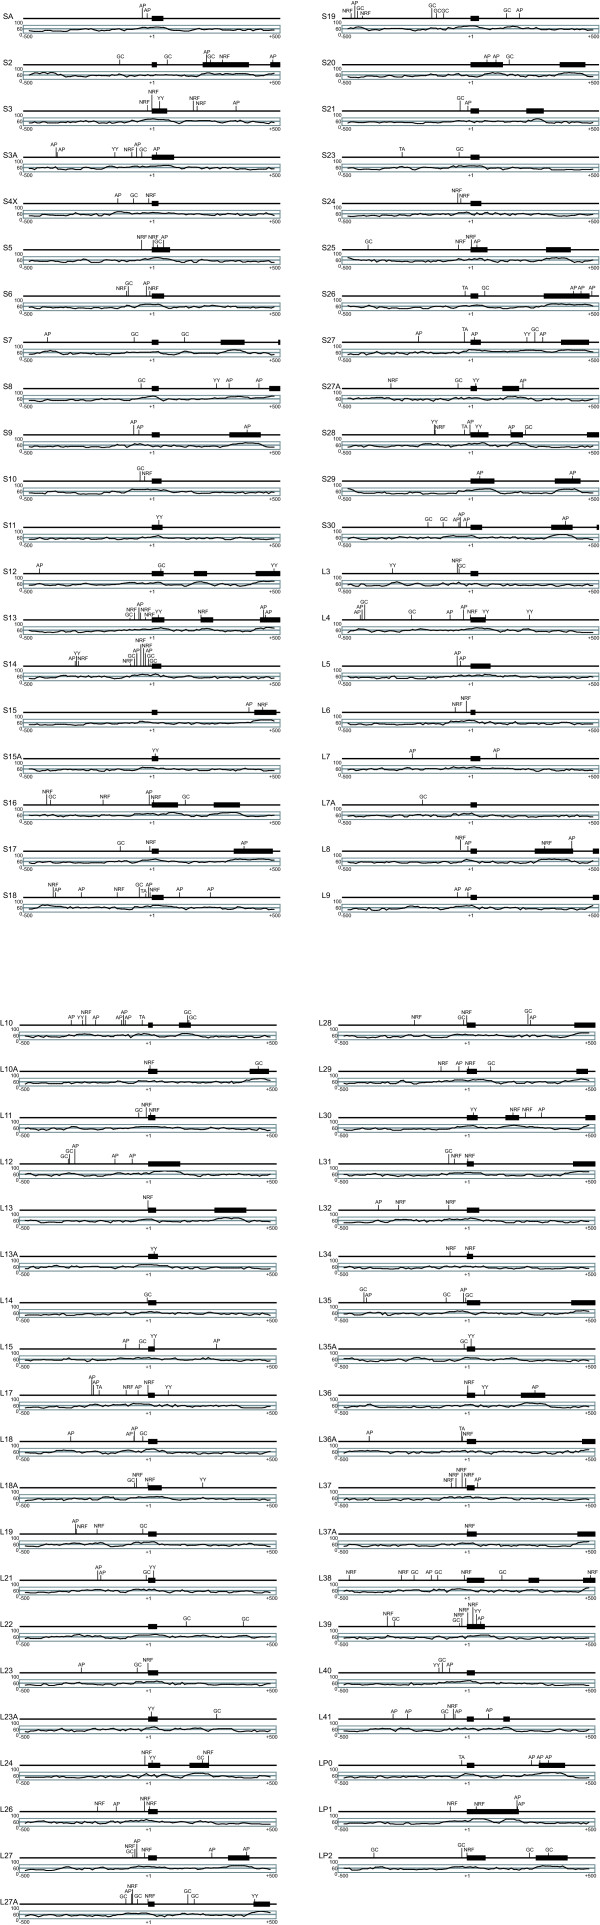
Transcription factor binding sites predicted by phylogenetic footprinting. The distance from the TSS (bp) is shown on the X axis, and the identity (%) with the orthologous mouse gene is shown on the Y axis. Black boxes indicate exons. Each thin line represents a location of a predicted promoter (NRF: nuclear respiratory factor 2; YY: Yin and Yang 1; GC: GC boxes; AP: activator protein 1; TA: TATA boxes).